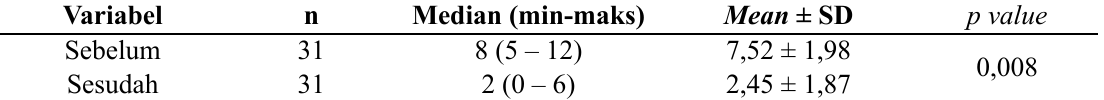
Tabel 3. Perbedaan kondisi depresi pada lansia sebelum dan sesudah terapi individu reminiscence